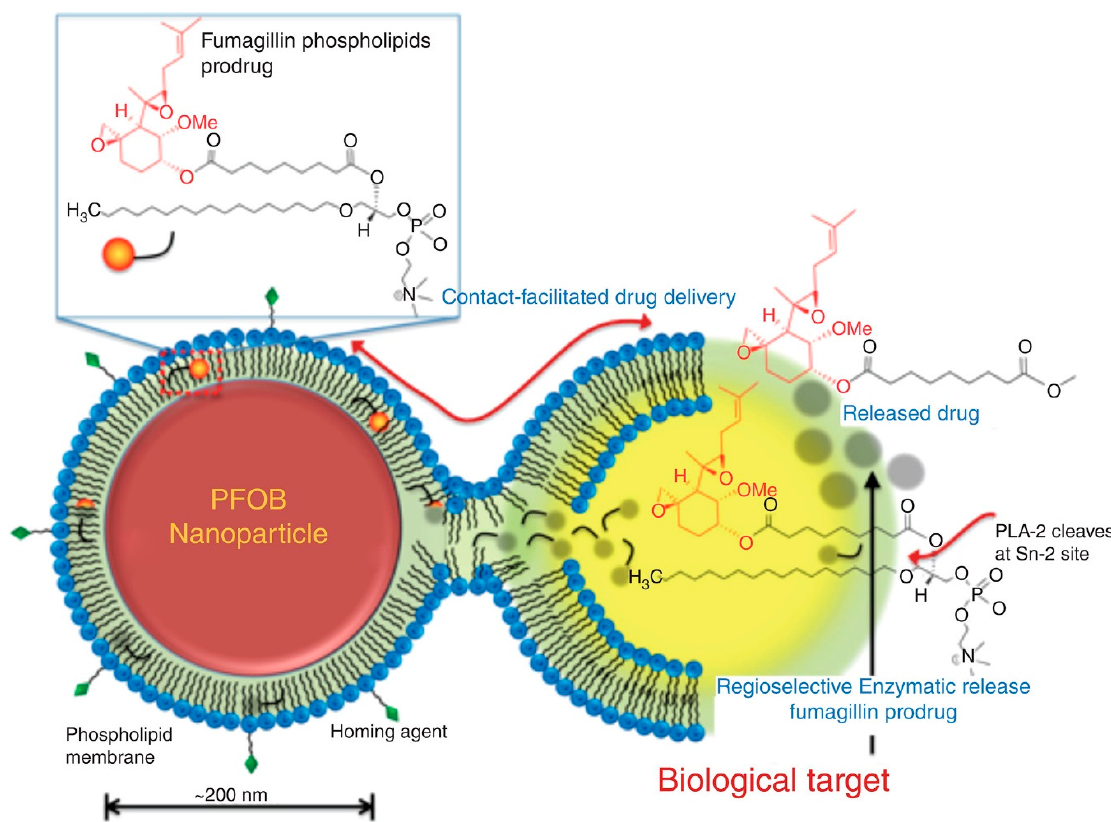
Figure 6. Illustration of contact-facilitated drug delivery mechanism where lipid membrane of PL-fumagillin containing nanoparticles. Binding of the nanoparticle to the targeted cell creates hemifusion complex between the two membranes, and PL-fumagilin prodrug is released into the cell, where local PLA 2 liberates the free drug into the cytosol. Reproduced with permission from reference [36], John Wiley and Sons, 2015.